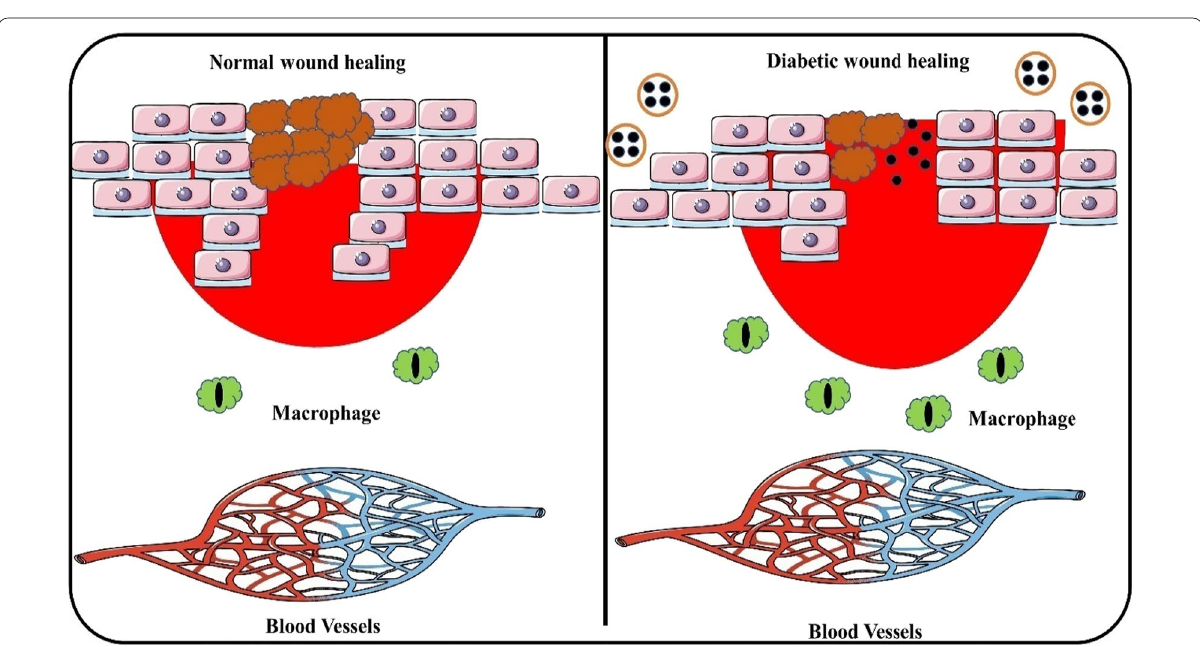
Fig. 17 Microsponges in diabetic wound